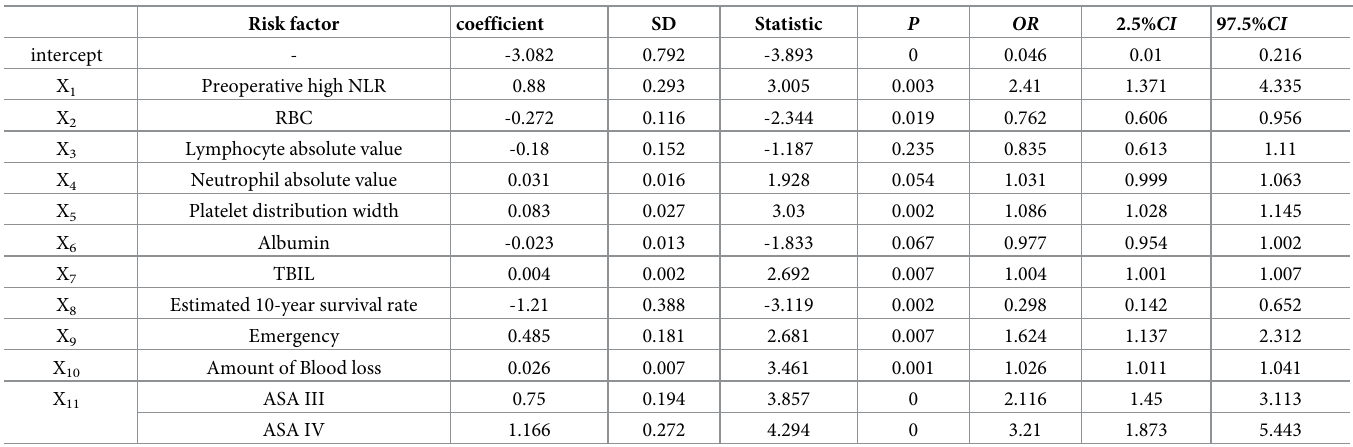
Table 2. The result from the lasso